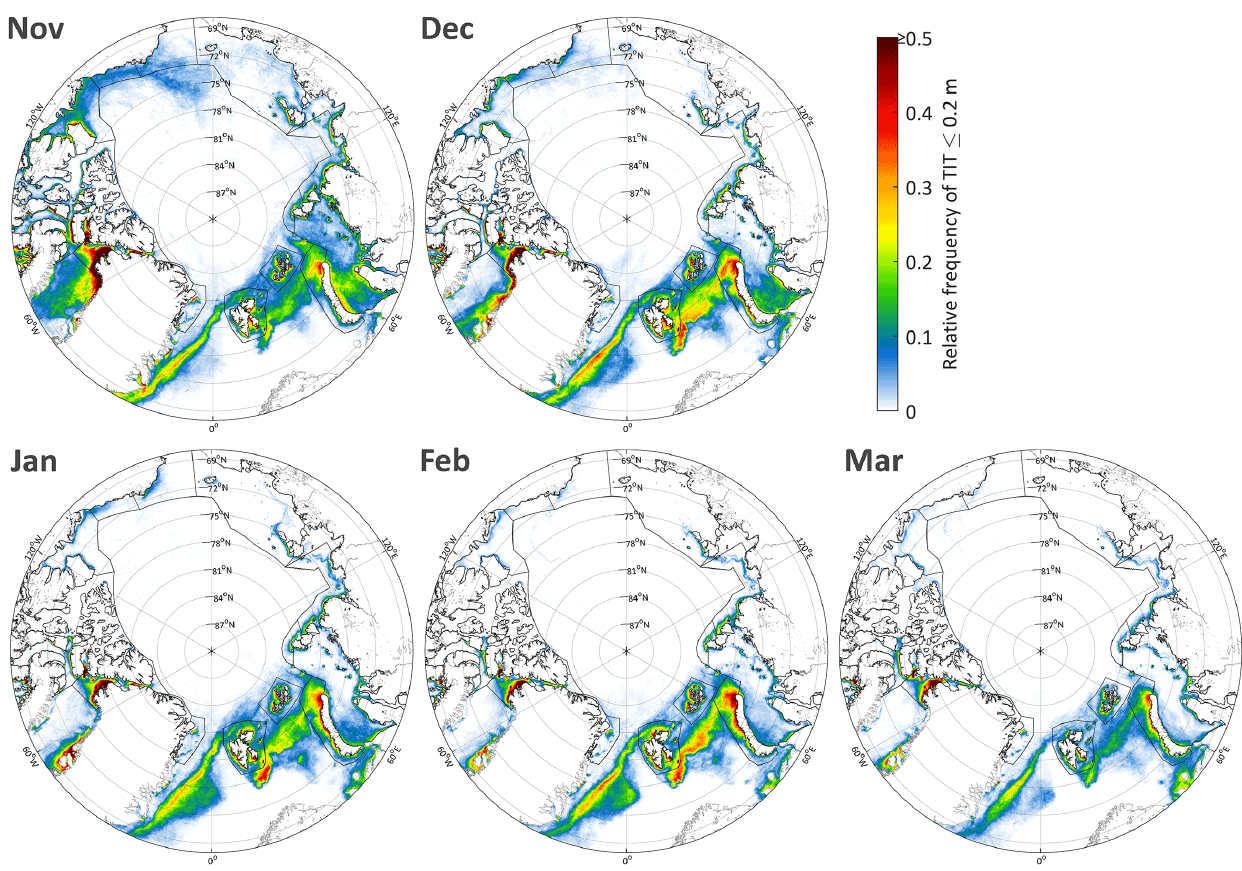
Figure 4. Average winter (November to March) frequencies of TIT ≤ 0.2m in the Arctic between winters 2002/2003 and 2014/2015. For each month, frequencies are calculated per pixel as the fraction of days with a TIT ≤ 0.2m relative to the 13-year investigation period. Note that only thin-ice areas within the margins of a given polynya mask (dashed black lines; see Fig. 1) are used for further analysis, while all other areas are discarded. Hence, areas with high TIT frequencies in the MIZ around the Fram Strait and northern Barents Sea are excluded from further analysis due to potential ambiguities originating from ocean heat fluxes and a high interannual variability of the MIZ in terms of location and